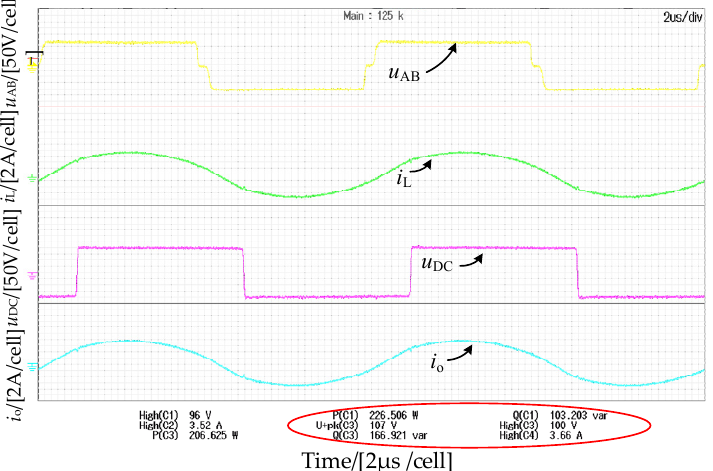
Figure 38. φ AD = 49 ° and φ AB = 190 ° experimental waveforms without reactive power optimization. From the above experimental waveform diagram, it can be seen that the reactive power of the phase-shift angle combination output by the flow chart is smaller than the reactive power of the randomly selected phase-shift angle, and it can be learned from the calculated efficiency that the system efficiency is the highest for the phase-shift angle combination output by the flow chart. The transmission efficiencies of the three phase-shift angle combinations are calculated for an output power of 200 W, as shown in Table